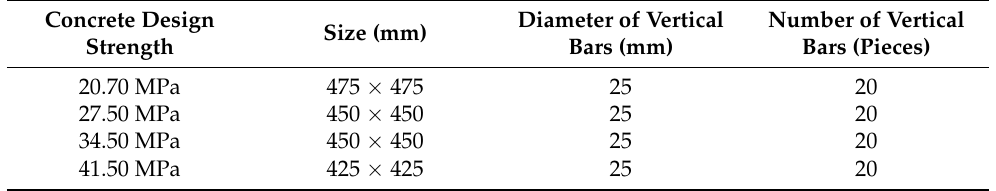
Table 8. Three-story building column reinforcement detail.